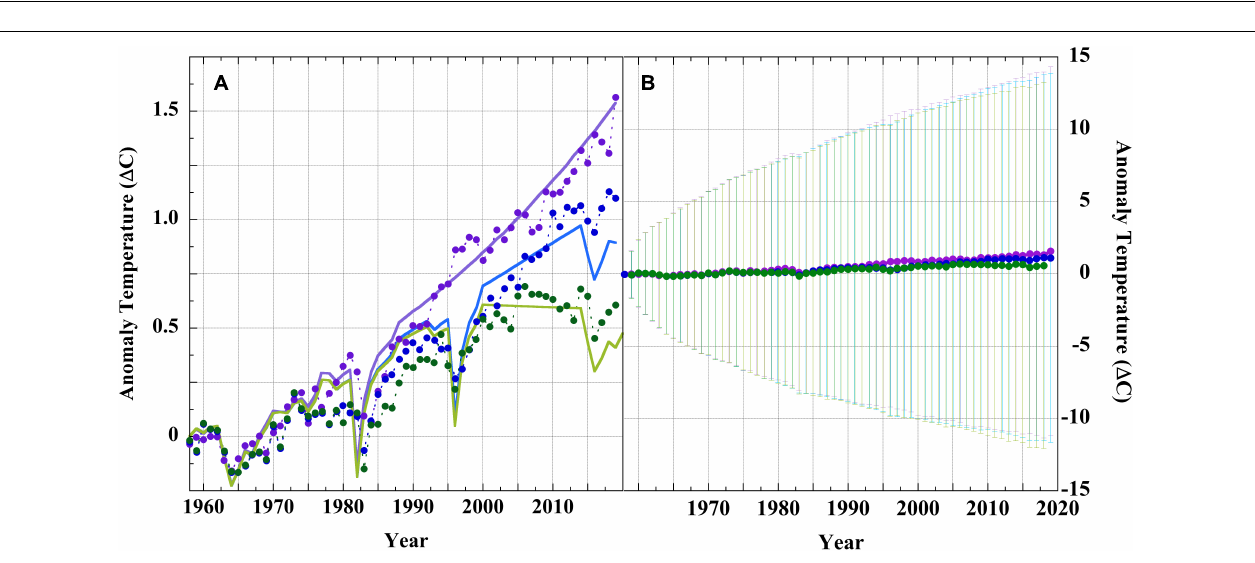
FIGURE 8 | Panel (A) : (points), historical air temperature projections of GISS Model II GCM for; ( • ), scenario A; ( • ), scenario B, and; ( • ), scenario C (Hansen et al., 1988; Schmidt, 2007a,b). (Lines), equation 1 emulation of: ( — ), scenario A; ( — ), scenario B, and; ( — ), scenario C, with Y 0 = 1958, T GHG (1958) = 33.25 K, f CO 2 = 0.42, F 0 = 33.946 Wm − 2 (CO 2 , N 2 O, and CH 4 forcing only). Panel (B) : The same A, B, and C scenario projections but with uncertainty bars from ± 4 Wm − 2 CMIP5-level LWCF calibration error propagated as equation